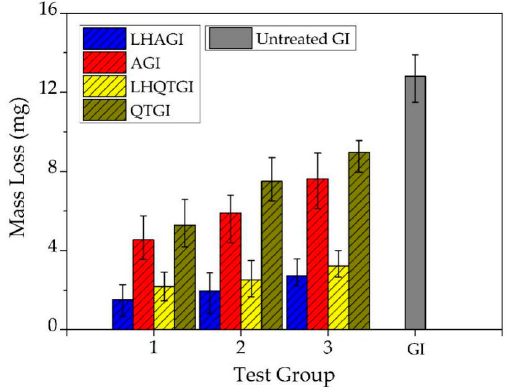
Figure 6. Mass Loss in the LHAGI, AGI, LHQTGI, and QTGI Specimens.